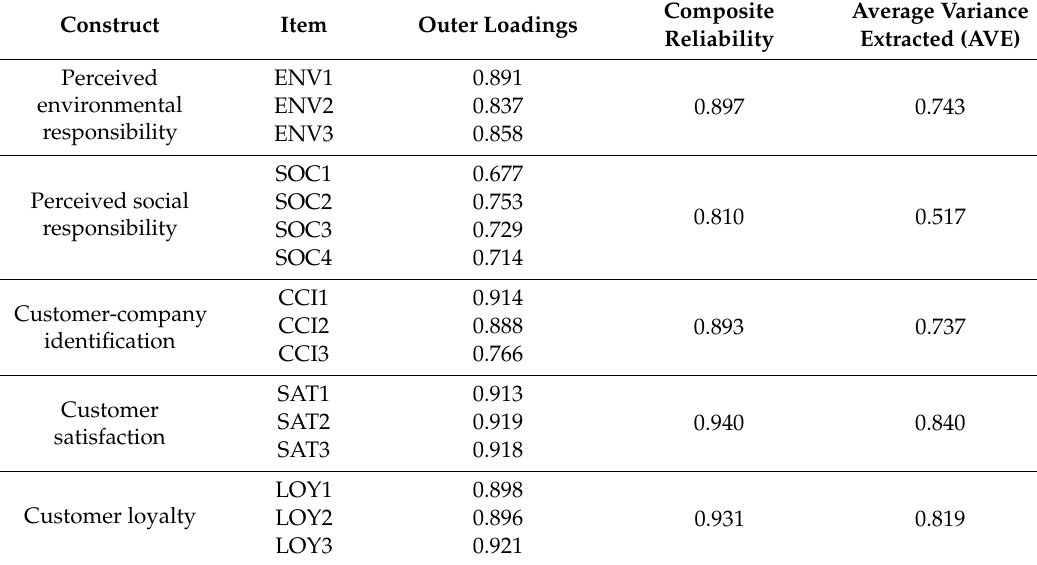
Table 4. Indicator reliability, construct internal consistency reliability and construct convergent validity